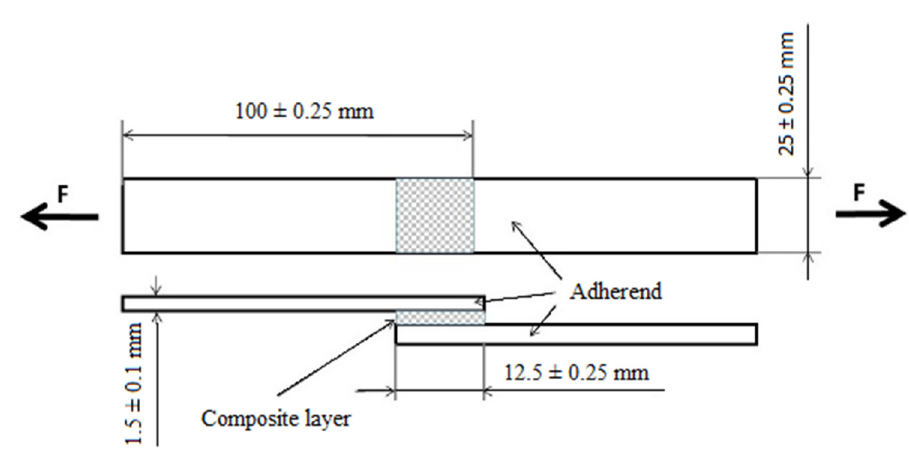
Figure 3. Scheme of the adhesive bond according to ˇCSN EN 1465 [36]. Table 1. Basic mechanical properties of steel S235J0 at a temperature of 20 °C [37].